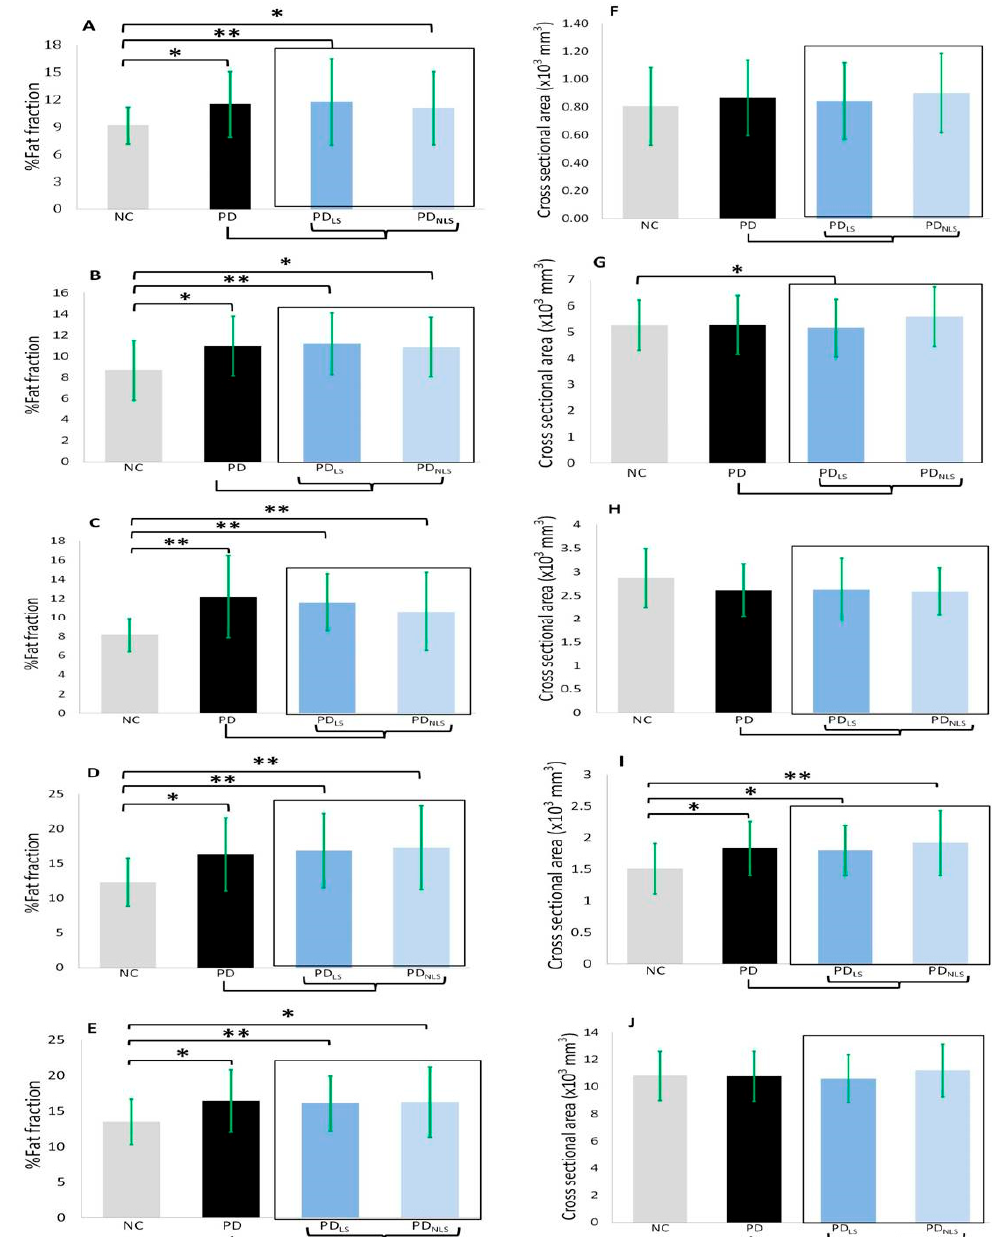
Figure 2. Fat fraction and cross-sectional areas of five ROI among NC, PD, lesion and non-lesion side of PD. A and F : psoas muscle; B and G : anterior compartment of thigh; C and H : medial compartment of thigh; D and I : posterior compartment of thigh; E and J : total compartment of thigh. Abbreviations: NC: normal control; PD: Parkinson’s disease; LS: lesion side; NLS: non-lesion side. Fat fraction and cross-sectional data were compared by analysis of covariance (ANCOVA) after controlling for age, sex and BMI. *: p < 0.05; **: p < 0.01.